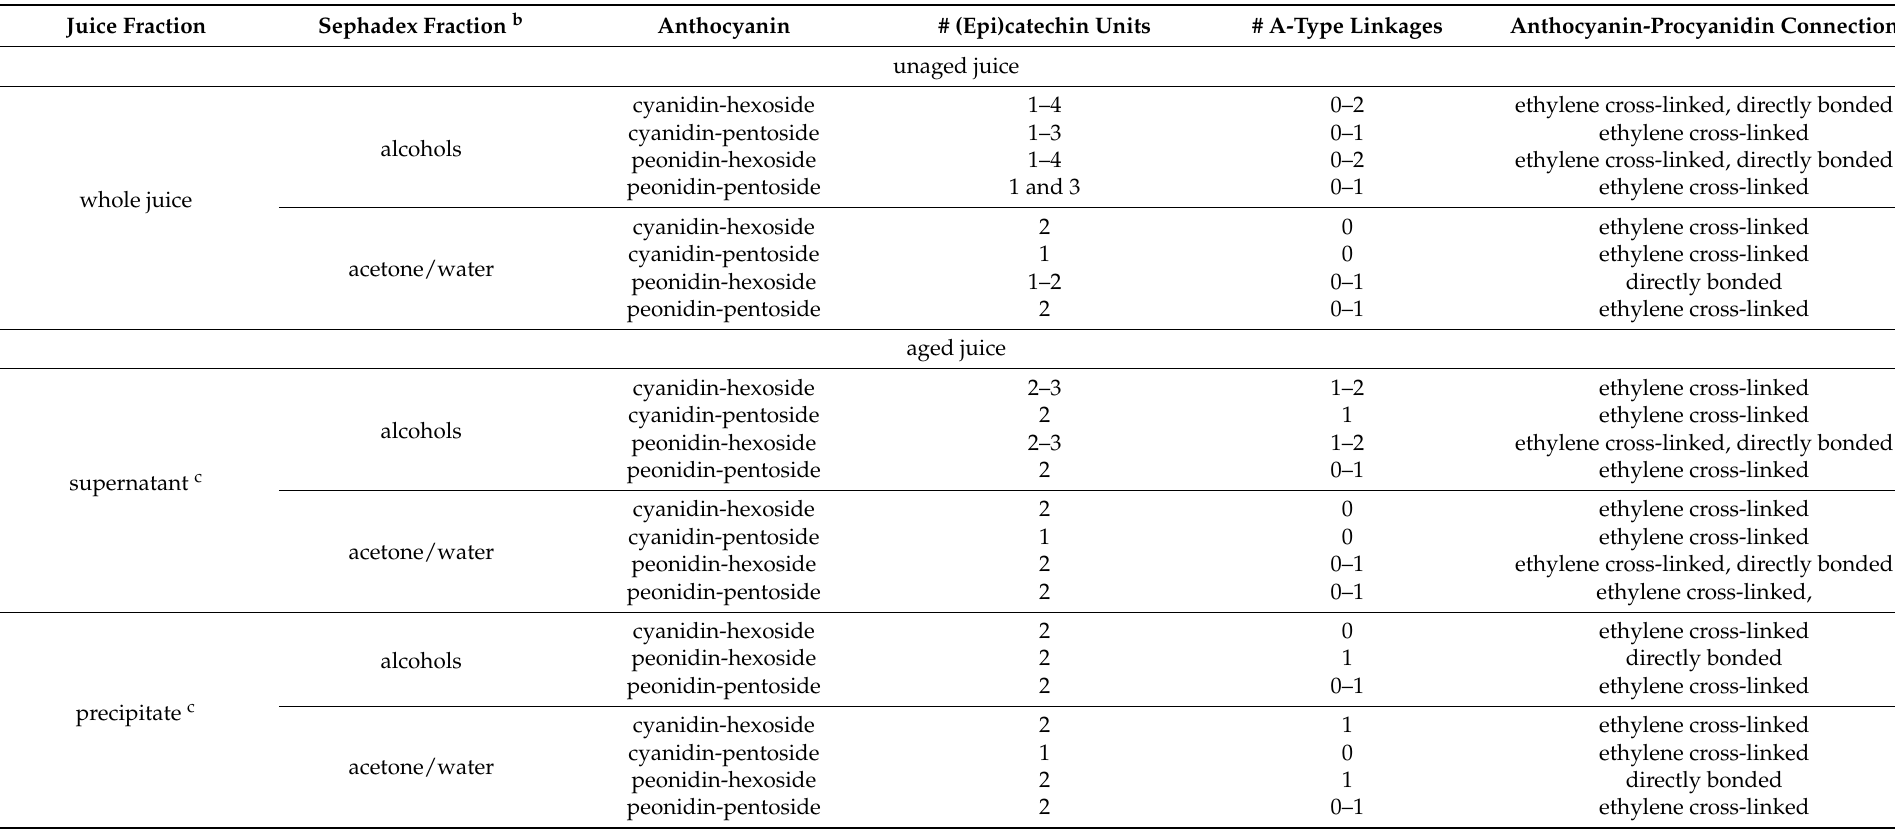
Table 3. Anthocyanin-proanthocyanidins tentatively identified in MALDI-TOF mass spectra of cranberry juice with 0 or 10 days accelerated aging at 50 ◦ C a